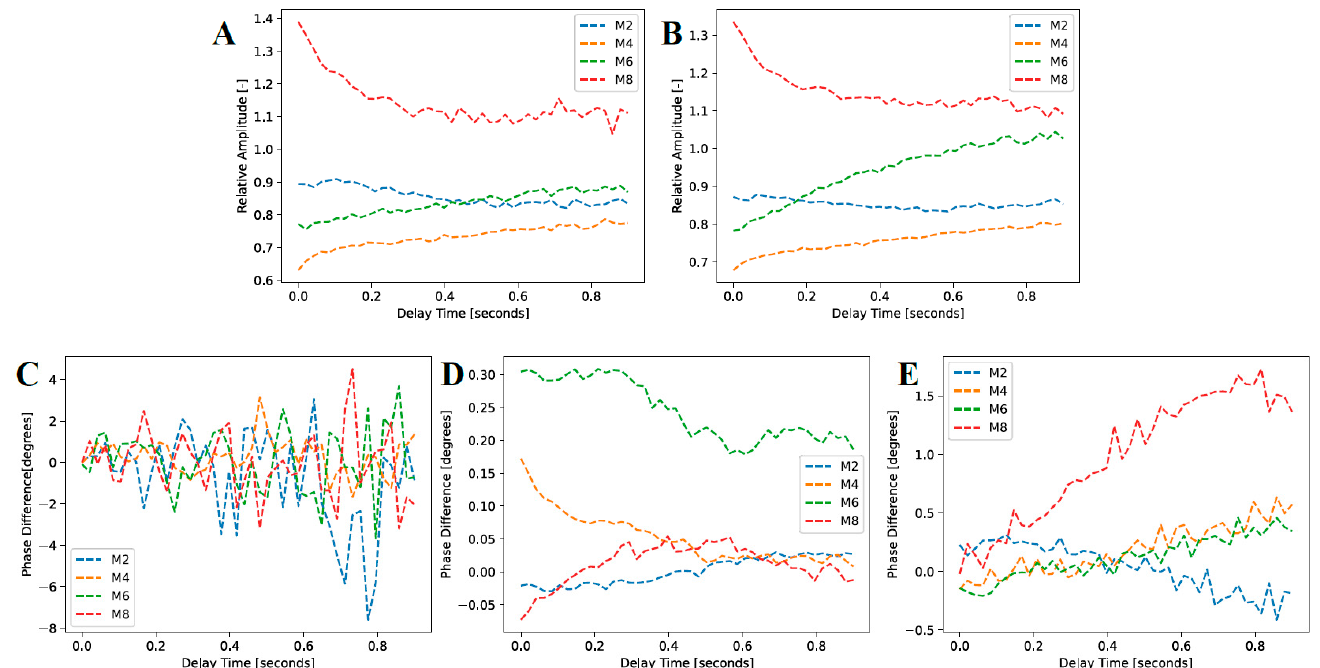
Figure 11. Mean amplitude and phase responses of the caries lesions and sound enamel regions highlighted in Figure 10 for ( A ) TC-PCT amplitude, ( B ) eTC-PCT amplitude, ( C ) TC-PCT phase, ( D ) eTC-PCT phase, and ( E ) TC-PCT LIOP.